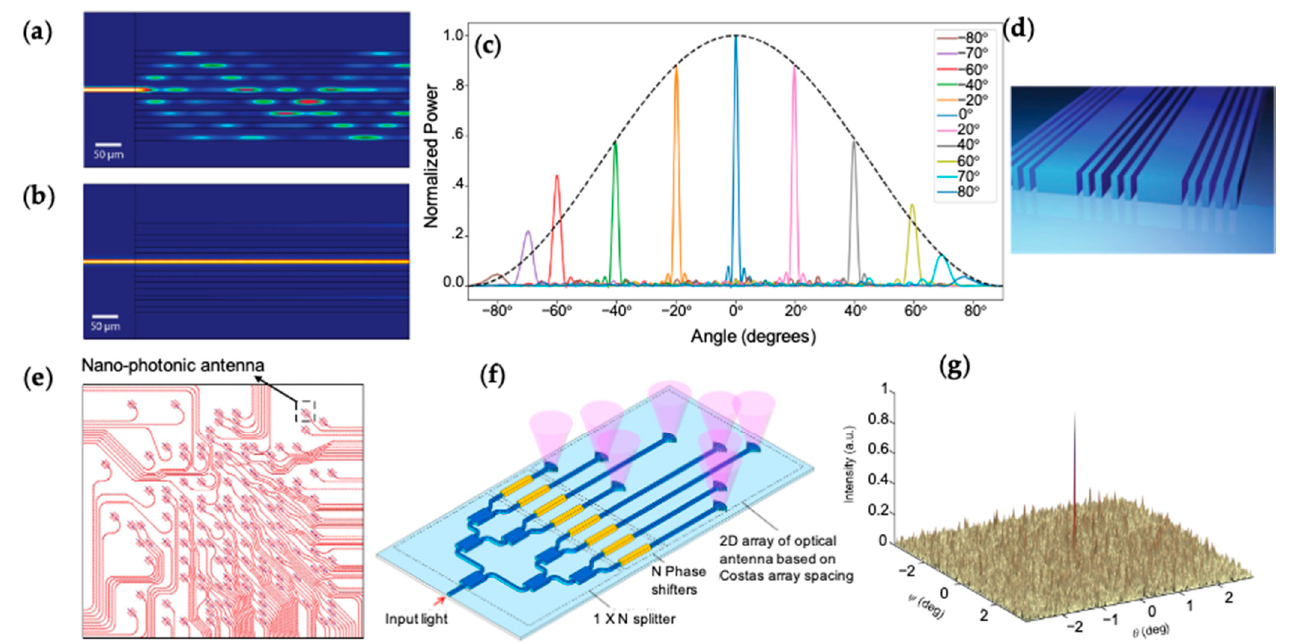
Figure 4. ( a ) Simulation of light propagation in an array of waveguides with equal width of 400 nm on (cid:2019) /2 pitch [41]. ( b ) Simulation of the phase-mismatched waveguide array with sequentially var- ying widths of 300, 350, and 400 nm [41]. ( c ) Measured far-field optical power versus output angle over a 180° FOV. Reprinted with permission from [41]. Copyright © 2022, Phare et al. ( d ) Control of the evanescent field by all-dielectric metamaterial between waveguides [42]. Copyright © 2022, Ja- hani et al. ( e ) A non-uniform 2D sparse OPA with 128 elements. © 2022 IEEE. Reprinted with per- mission, from [35]. ( f , g ) Schematic of a 2D Costas array and the measured far-field beam profile. Adapted with permission from [32] © The Optical Society.